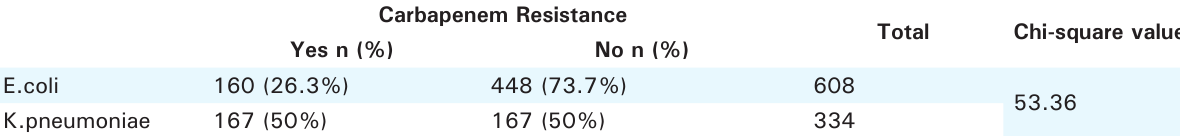
Figure 2. Carbapenem Resistance Among Enterobacteriaceae.